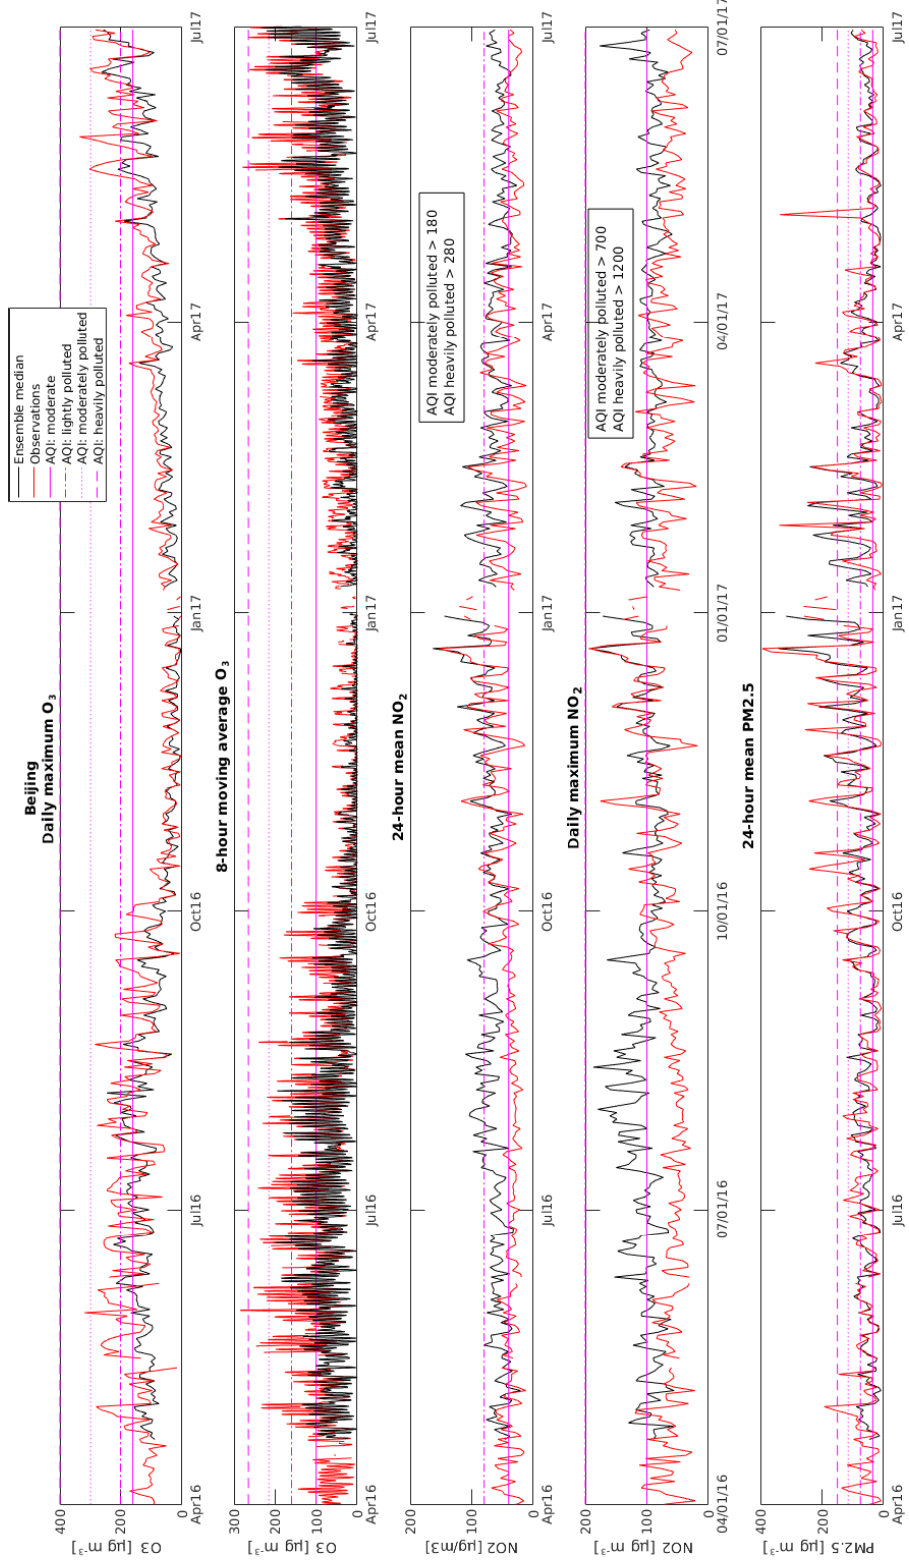
Figure 10. Time series of daily maximum O 3 , 8h moving average O 3 , 24h mean NO 2 , daily maximum NO 2 , and 24h mean PM 2 . 5